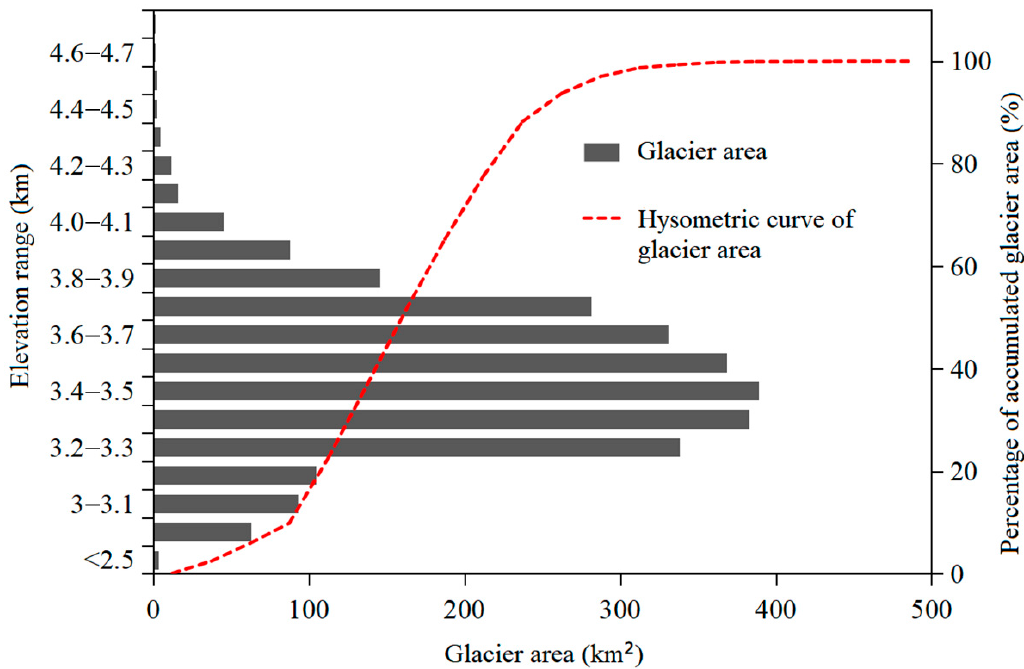
Figure 8. Distribution of glacier area at different altitudes in the northern Tien Shan.